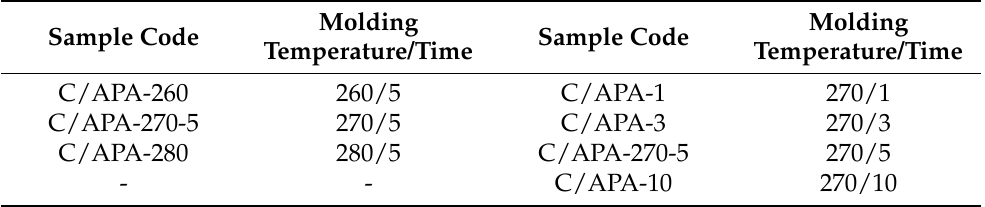
Table 2. Sample code of Carbon/APA composites prepared at different molding